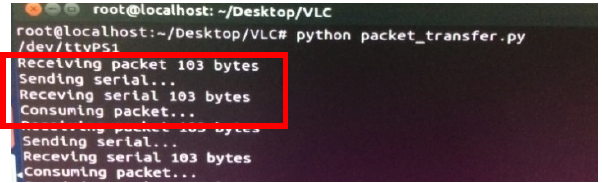
Figure 16. A photograph of the PC monitor connected